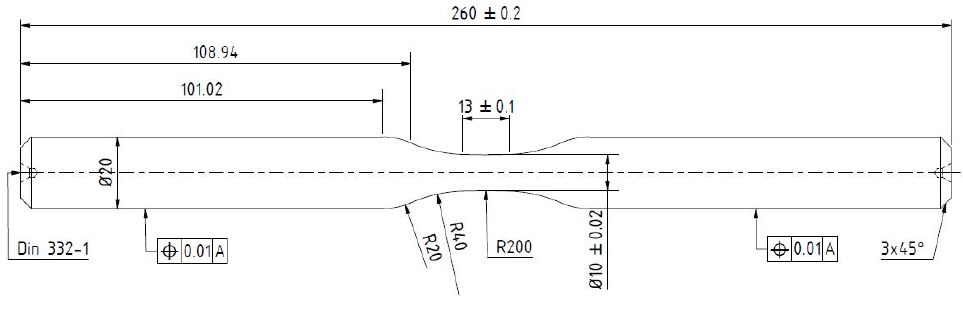
Figure 1. Specimen geometry.